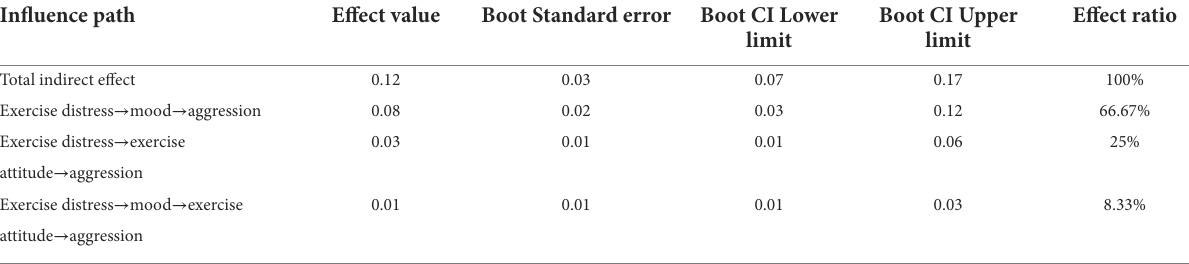
TABLE 3 Decomposition table of complete mediating effects of exercise